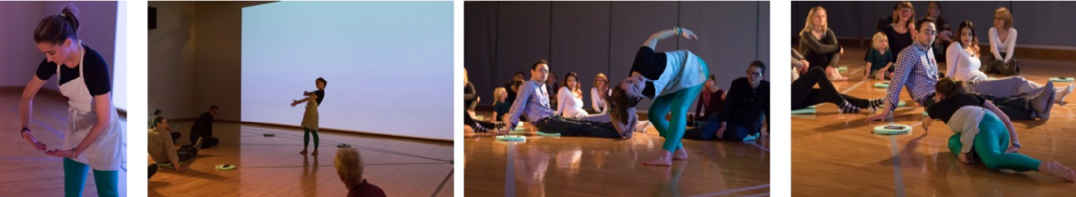
Figure 3. A movement section exploring the limits of the physical body and the segmented space is accompanied by the ringing of cell phones in a canon (one phone breaks silence and then is slowly joined by all 13 phones onstage). The performer stays inside one cell (this is a discrete statement), tracing its edges and finding unusual poses created by trying to move each joint in succession, trying out the Cartesian product of all joint angle ranges. Photos by Natalie Fiol.